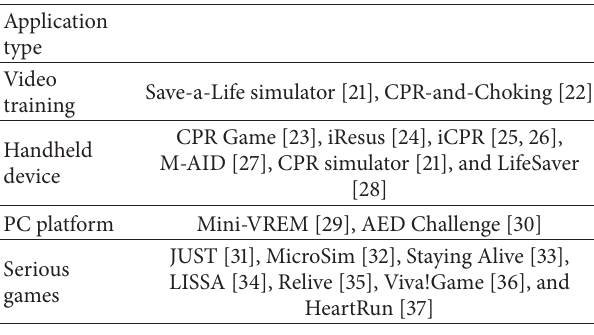
Table 1: Some of the proposed applications to introduce CPR or some of the steps of the